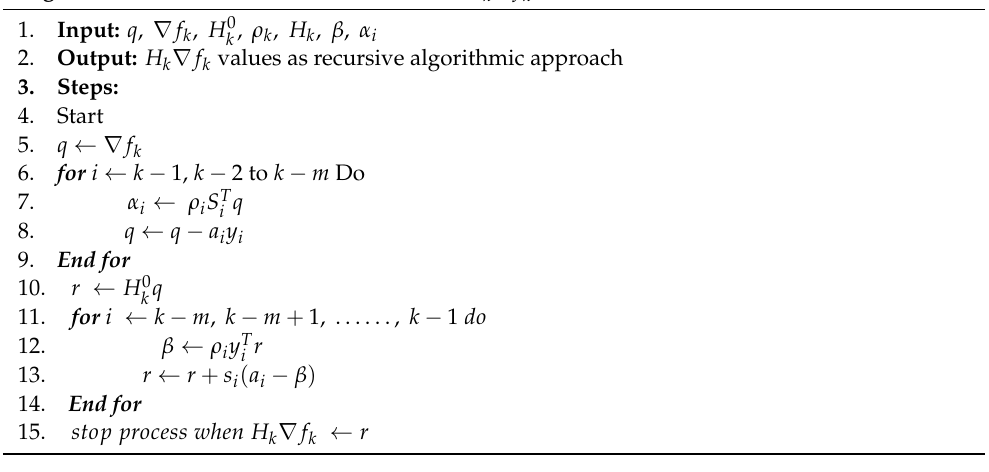
Algorithm 1: L-BFGS Recursion to Calculate H k ∇ f k